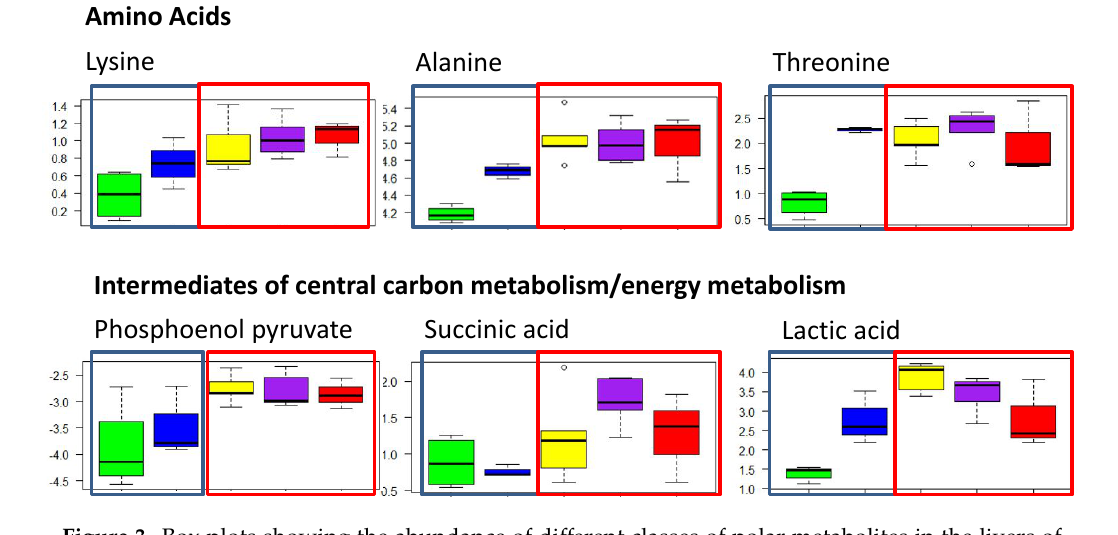
Figure 3. Box plots showing the abundance of di ff erent classes of polar metabolites in the livers of female sand flathead collected from five sites ( n = 3–6 fish per site) around Port Phillip Bay, Victoria, Australia in March 2015. Green = Sorrento, blue = St Leonards, yellow = Corio Bay, purple = Mordialloc, and red = Hobsons Bay. Blue outline represents the rural sites, red outline represents the urban